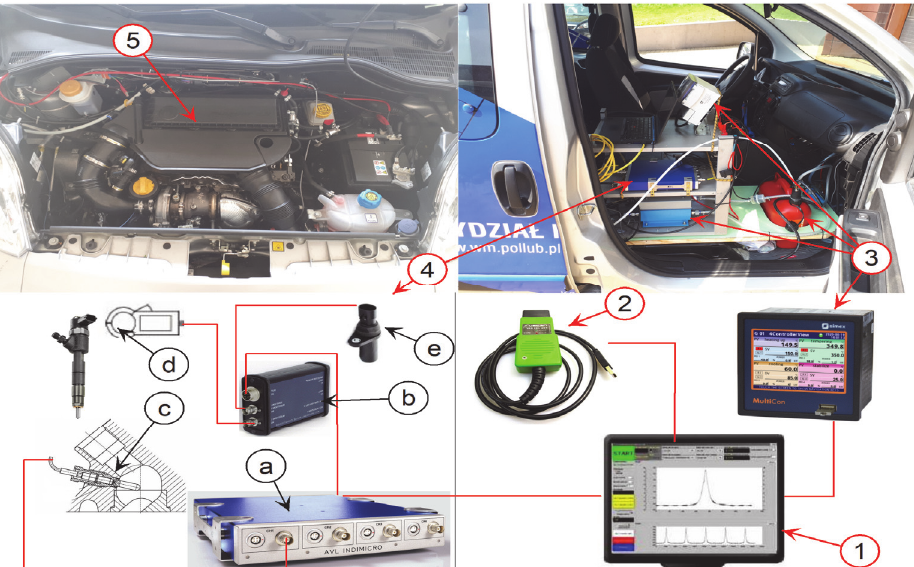
Figure 2. Control, measuring and recording apparatus: 1. mobile computer with IndiCom software from AVL, V.07 flow meter, FIAT Multiecuscan, 2. Multiecuscan diagnostic interface, 3. Auxiliary fuel system tank with meter from Rotameter company with Multicon CMC-99 Simex module, 4. Engine indexing system and components: (a) AVL IndiMicro 602 measuring module, (b) AVL Universal Pulse Conditioner 389Z01 transducer, (c) AVLGH13P piezoelectric sensor in I cylinder glow plug socket, (d) Current clamps connected to I cylinder injector, (e) Induction engine speed sensor, 5. Diesel engine meeting EURO 5 exhaust gas standards .